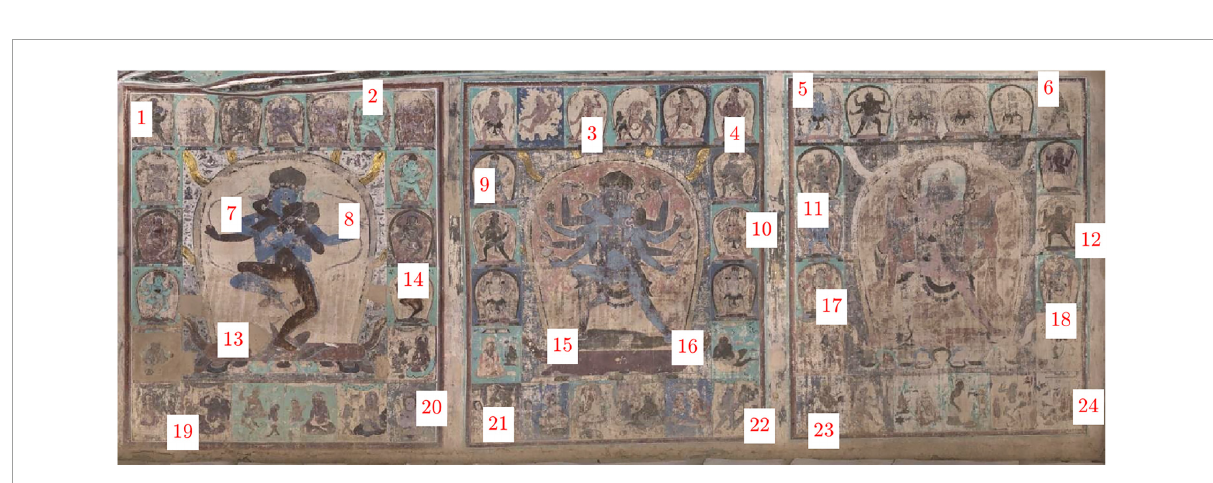
FIGURE6 Coordinates of selected reference samples in the basal layers of the murals.